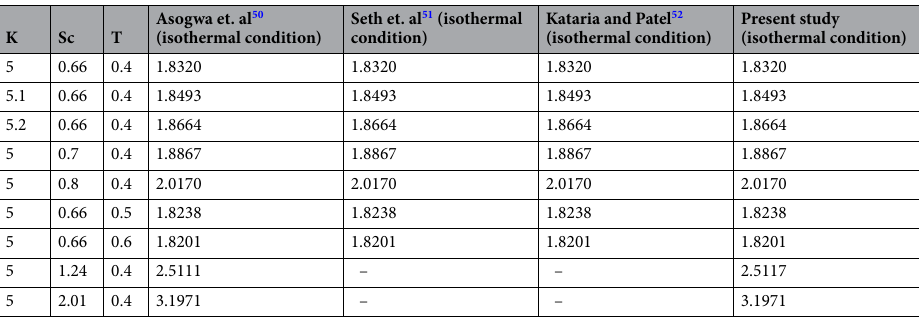
Asogwa et. al 50 (isothermal